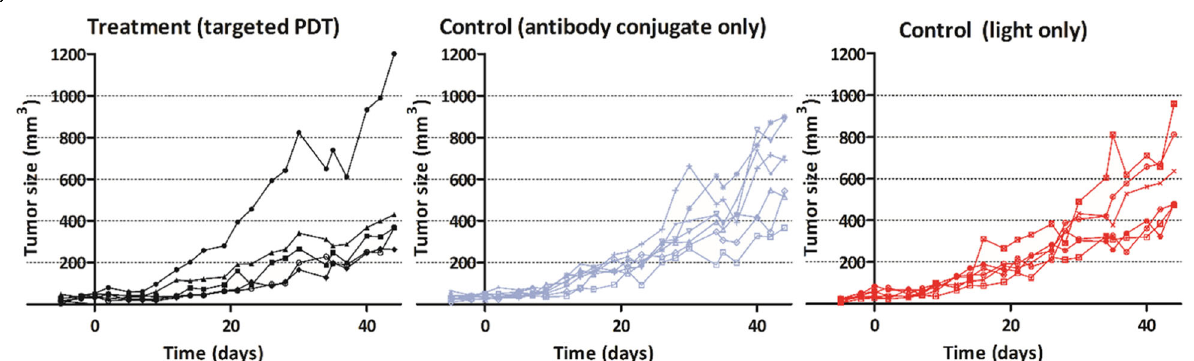
Fig. 3 In vivo tumor growth progression after targeted PDT treatment (day 0) and control conditions followed up three times per week. The two control groups: DTPA-hMN-14-IRDye700DX only group (without light exposure) in blue and the light-only group in red. Only 5 mice were treated due to a technical incident during the treatment of the 6th mouse. In general, mice in the tPDT (treatment) group show a delayed tumor growth pattern. One of the treated mice had a more aggressive growth